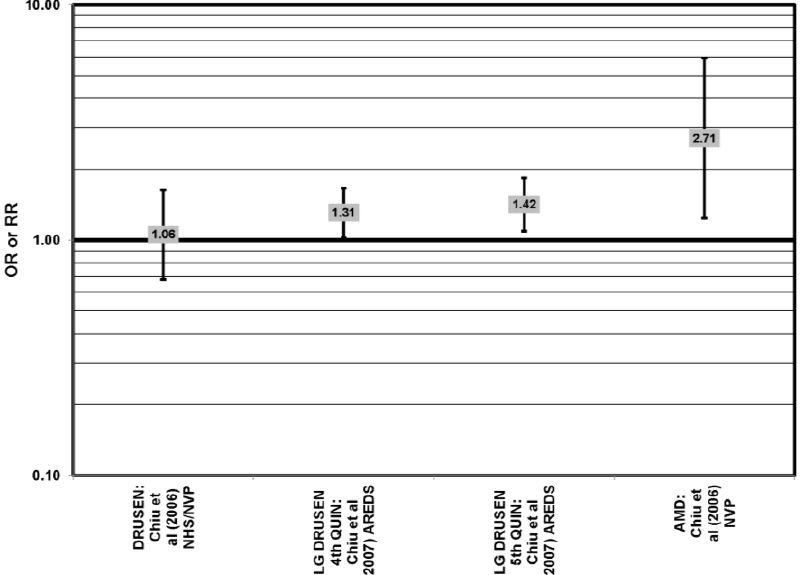
Figure 1. Odds or risk ratio for early age-related macular degeneration (AMD) indicators (DRUSEN), late AMD indicators (LG DRUSEN) or AMD with intake of a high glycemic index diet: cross-sectional